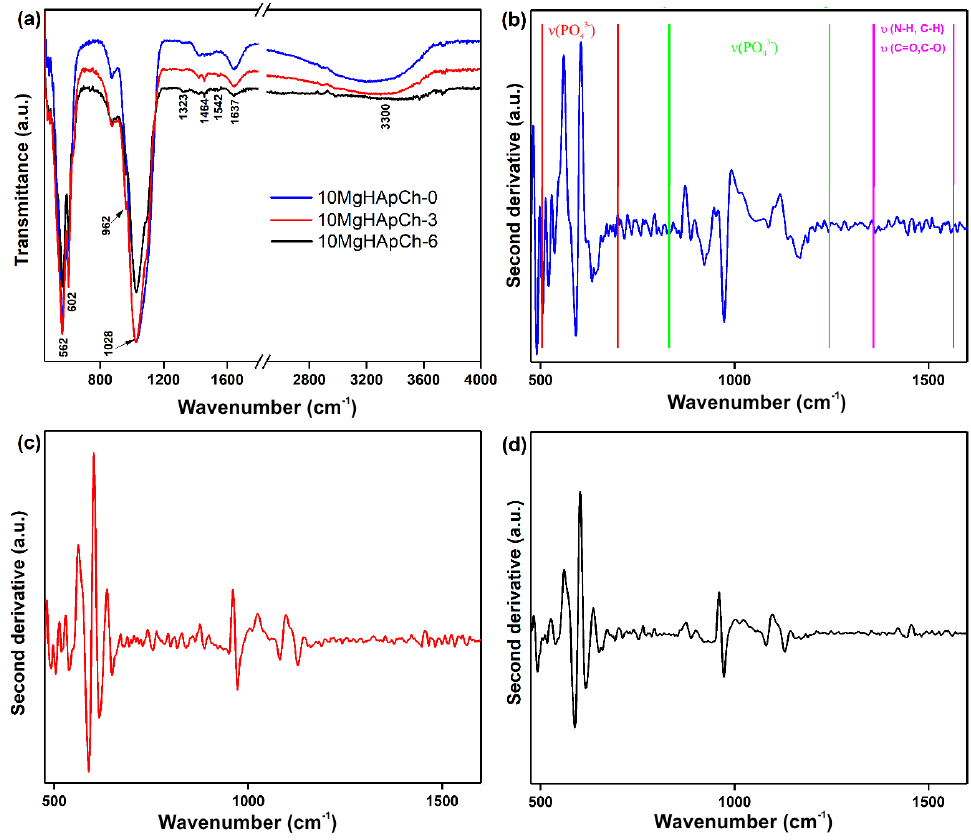
Figure 13. ATR-FTIR spectra of 10 MgHApCh thin films ( a ) and second-derivative spectra obtained for 10 MgHApCh-0 ( b ), 10 MgHApCh-3 ( c ), and 10 MgHApCh-6 ( d ) thin films.